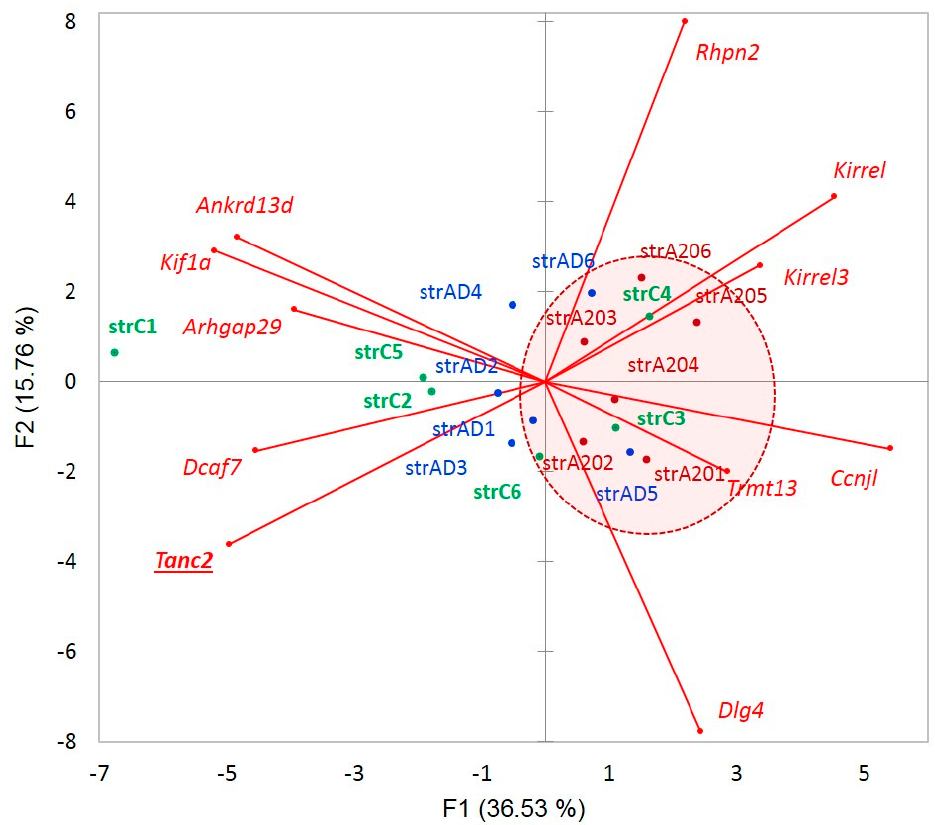
Figure 13. In total, 11 genes were recovered as a closest connected network environment of Tanc2 from string-db.org (GO 0030425: ‘dendrite’, Tanc2 , Kif1a , Dlg4 , Kirrel , and Kirrel3 ; FDR < 0.003) shows a distinct gradient in the expression specifics of the samples. We speculate that a definite lack of a short isoform in A20 mice (Figure 2) may correlate with the attenuation of Tanc2 expression displayed in aggressive mice: a nonrandom distribution of A20 mice in the right part of the plot (red encircled) rejects the null hypotheses with p < 0.0015 (binomial test).